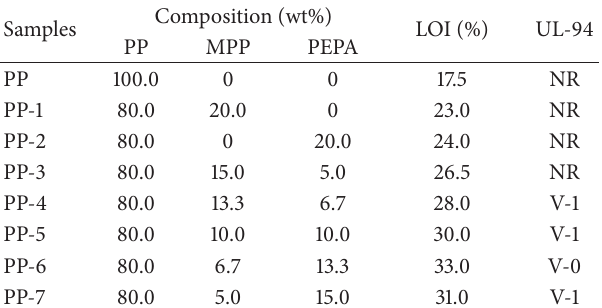
Table 4: TGA characteristic parameters of PP and the flame retardant PP under air